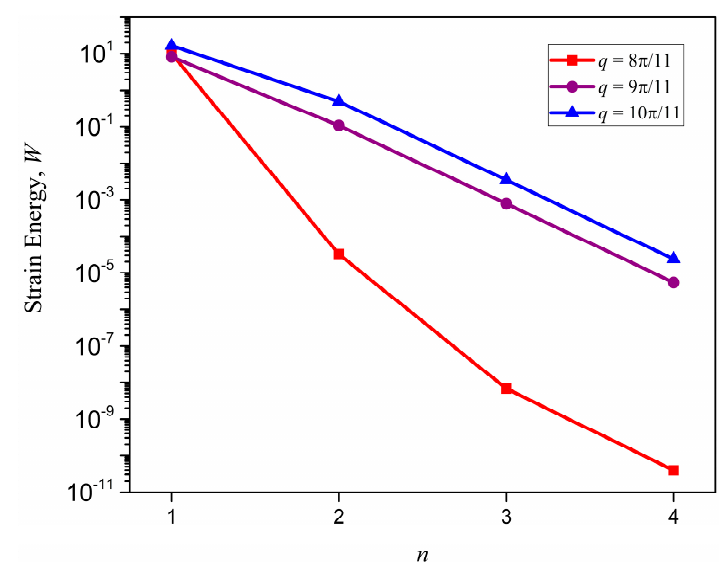
Figure 9. Strain energy along the index, n , in an x-braced lattice with k = 0.93: The fastest total strain energy decay occurs at q = 8 Saint-Venant’s effect.